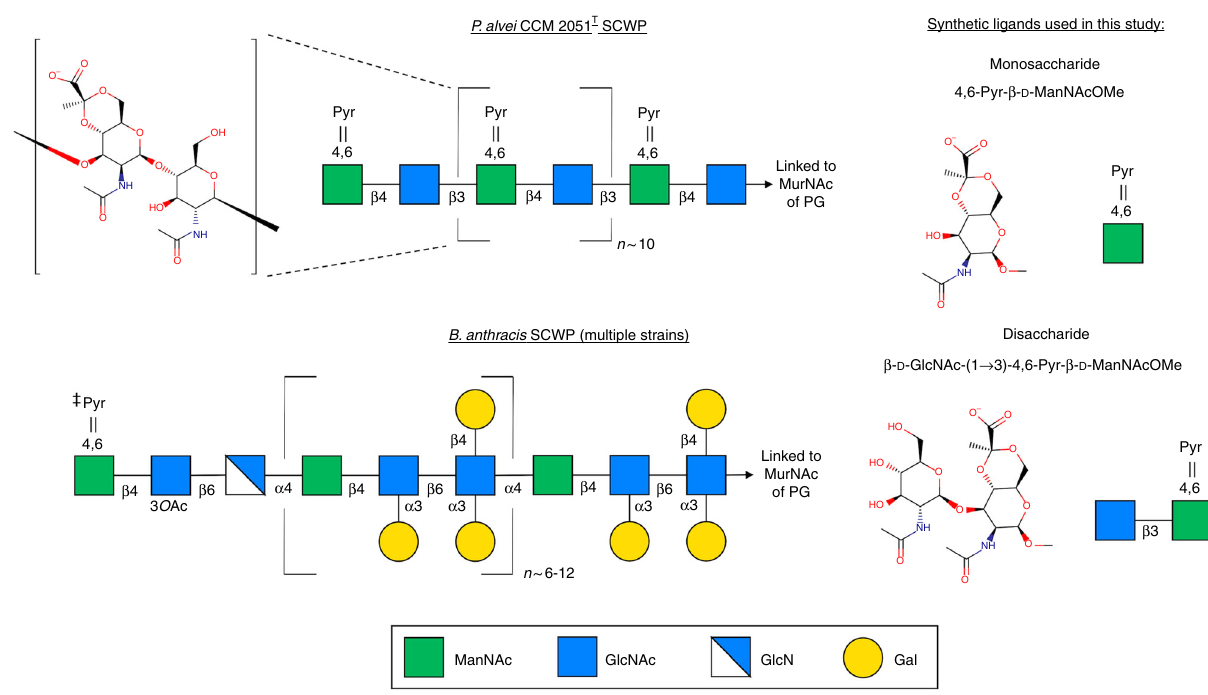
Fig. 2 SCWP structures and synthetic ligands used in this study. Schematic diagrams of the SCWP from P. alvei CCM 2051 T and B. anthracis (multiple strains) are shown on the left, with a detailed chemical diagram of the repeating unit shown for the former 8, 37, 40, 43, 44, 61 . The synthetic ligands used in this study, representing building blocks of P. alvei CCM 2051 T SCWP, are shown on the right. ‡ Pyruvylation, O -acetylation, and N -deacetylation of the terminal trisaccharide repeat were determined for B. anthracis Ba684 40 . There remains some uncertainty in the extent of pyruvylation of some B. anthracis SCWPs, because the use of HF to cleave SCWPs from PG also liberates the acid-sensitive ketal groups 8